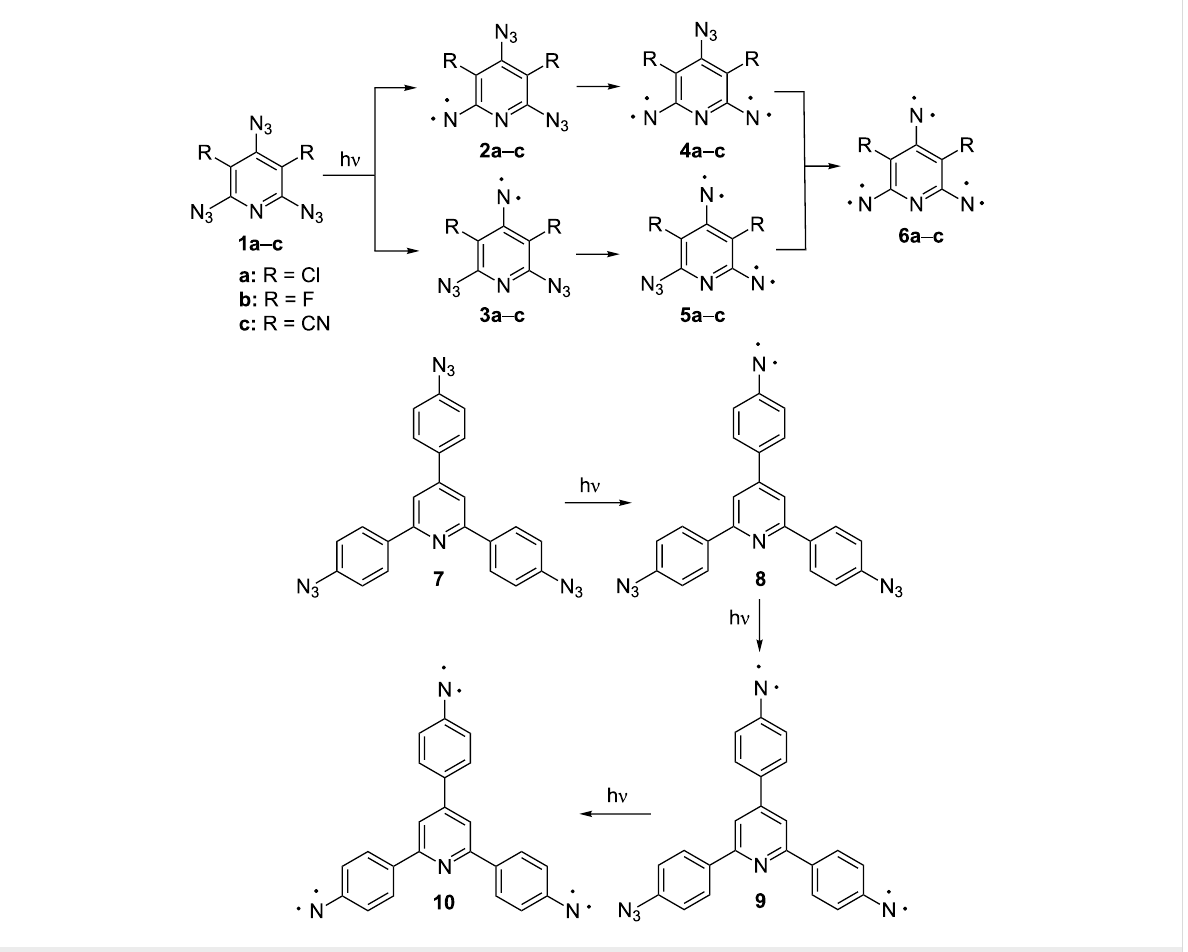
Scheme 1: Examples of selective photolysis of the azido